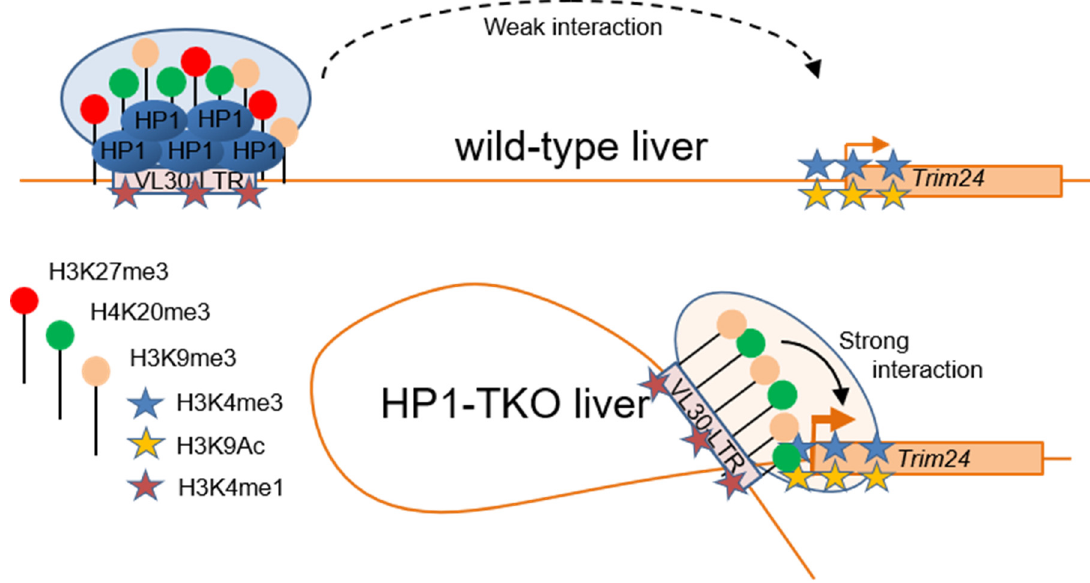
Figure 5. A model for HP1-dependent VL30-LTR ERV transcription control at the Trim24 locus. In wild-type liver, the RLTR-86 VL30-LTR is covered by a repressive complex (blue shaded oval) triggered by H3K9me3, H4K20me3 and H3K27me3 repressive marks in the presence of the H3H4me1 enhancer mark. This peculiar epigenetic bookmarking prevents the long-range interaction of this ERV with the Trim24 promoter. Upon loss of HP1 (HP1-TKO), H3K27me3 is specifically decreased leading to the release of the repressive complex and recruitment of specific transcription factors (pale orange oval), thus allowing the association of this ERV with the Trim24 promoter and increasing the expression of this gene.